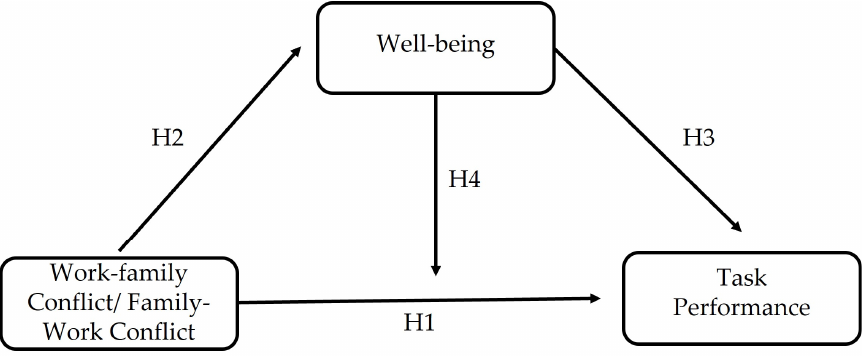
Figure 1. Research Model.